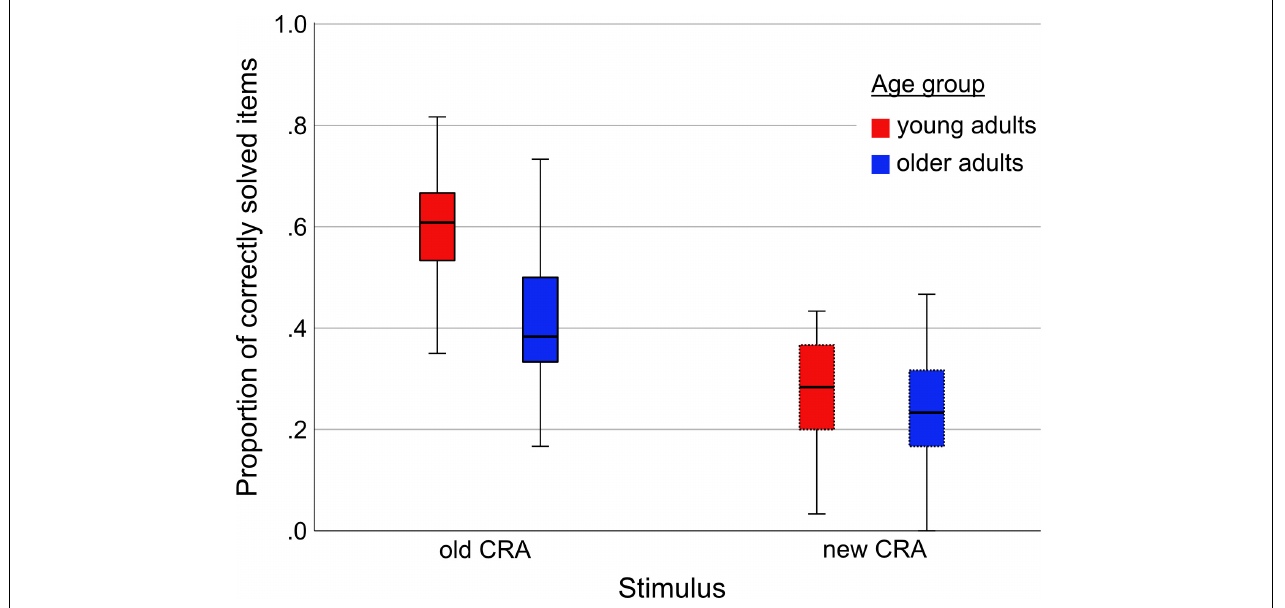
FIGURE 3 | Proportion of correctly solved CRA items by Stimulus (old, new) and Age group (young, older).